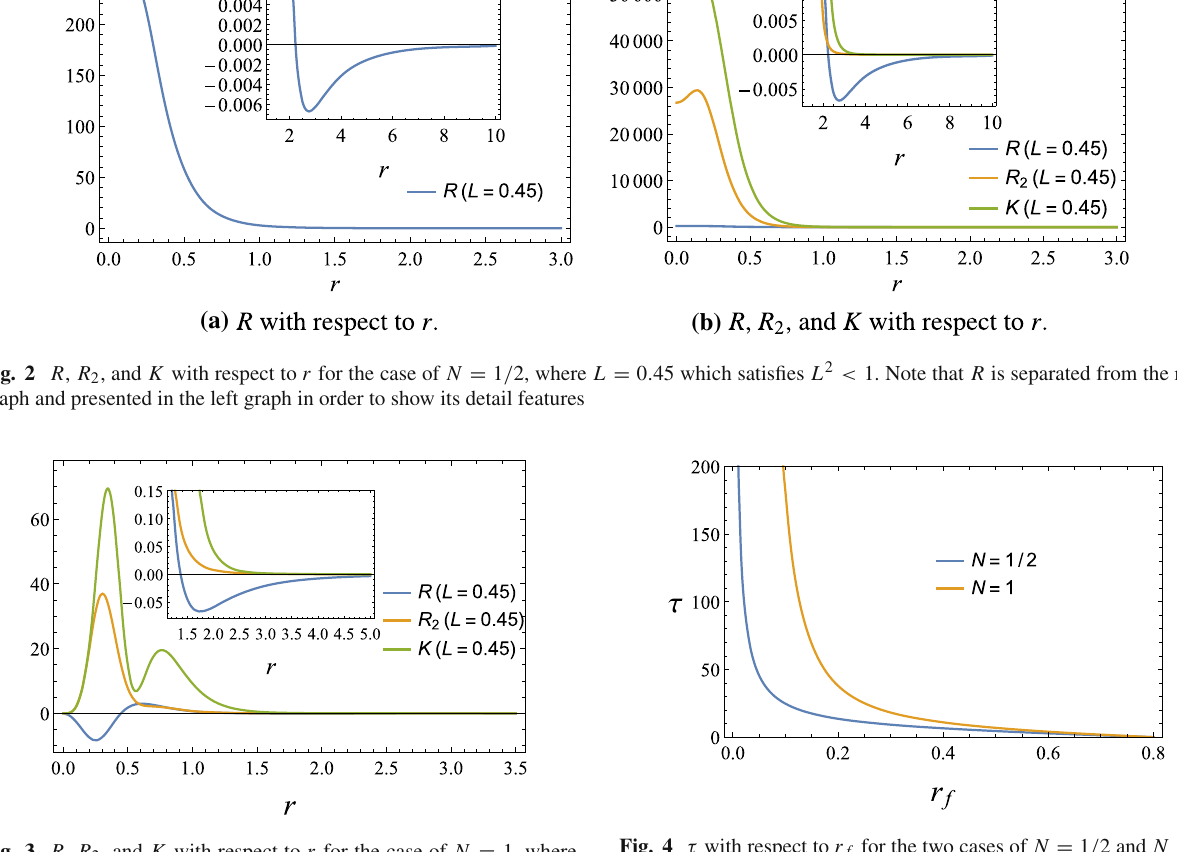
Fig. 3 R , R 2 , and K with respect to r for the case of N = 1, where L = 0 . 45 which satisfies L 2 ≤ 1 / 4